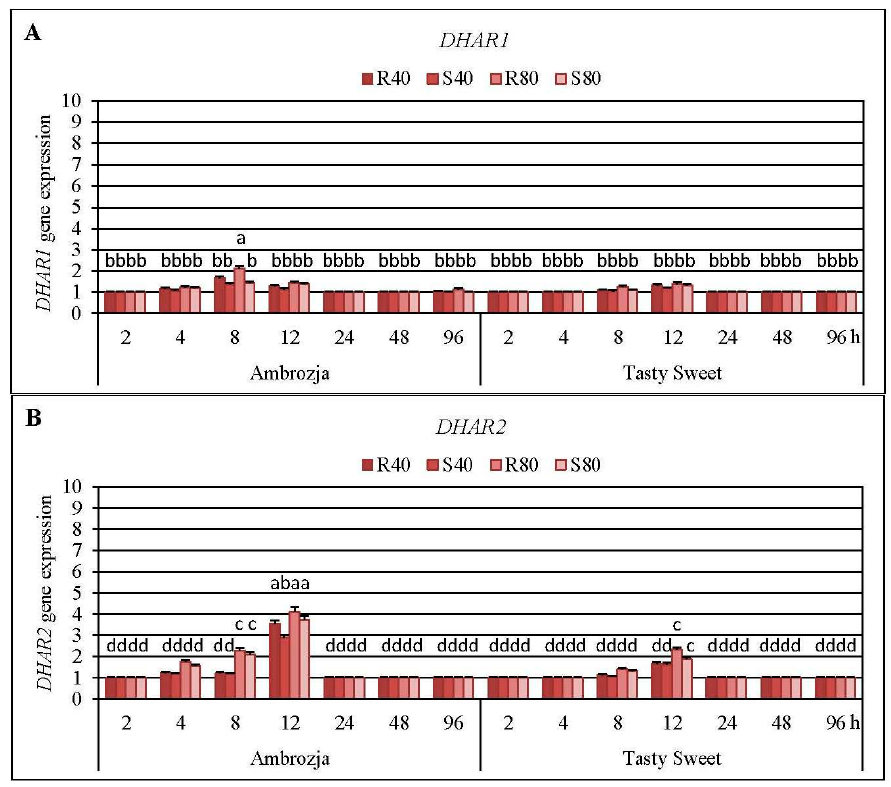
Figure 7. Effect of the cereal aphid’s herbivory on relative expression of DHAR1 ( A ) and DHAR2 ( B ) genes in the seedlings of Ambrozja and Tasty Sweet maize varieties (first phase of the experiments). R40, R80—maize plants of a certain genotype infested with 40 or 80 R. padi females per seedling, accordingly; S40, S80—maize plants of a certain genotype infested with 40 or 80 S. avenae females per seedling, respectively. All data are presented as the mean (±SD) of three independent biotests, and significant differences in abundance of the DHAR transcripts are denoted by different letters ( p < 0.05; post-hoc Tukey’s